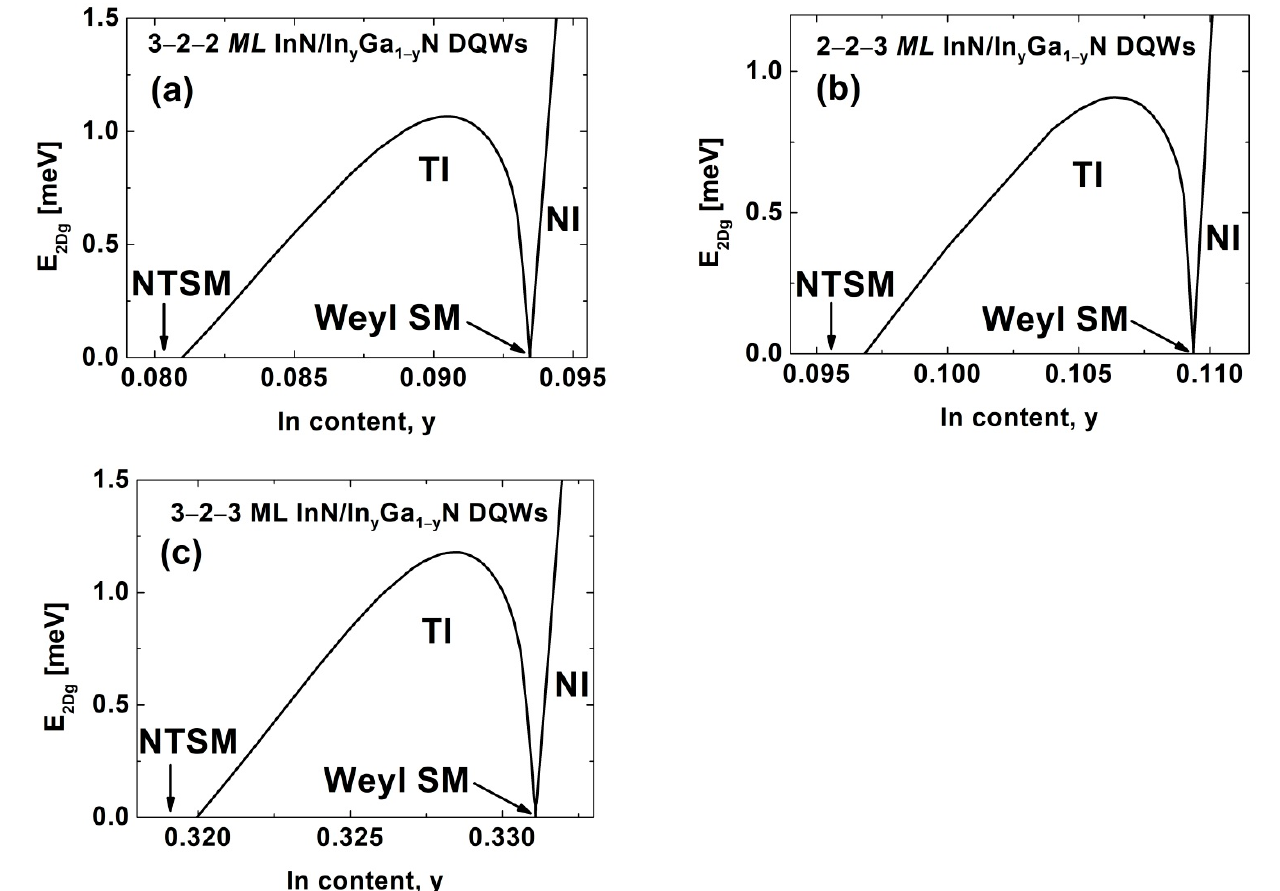
Figure 4. The E 2 Dg as a function of the In content in the barriers for InN/In y Ga 1 − y N DQWs with ( a ) L qw , A = 3 MLs , L qw , B = 2 MLs , and L ib = 2 MLs ; ( b ) L qw , A = 2 MLs , L qw , B = 3 MLs , and L ib = 2 MLs ; and ( c ) L qw , A = 3 MLs , L qw , B = 3 MLs , and L ib = 2 MLs